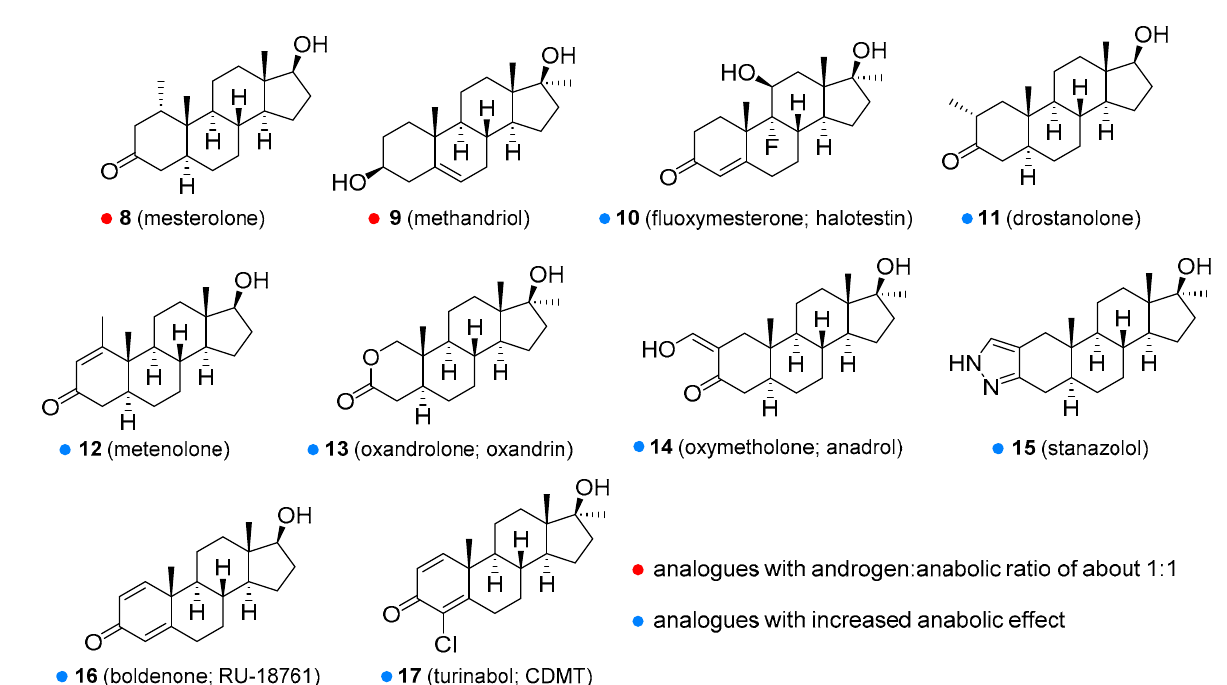
Figure 3. Some of the synthetic testosterone analogues (synthetic anabolic steroids).